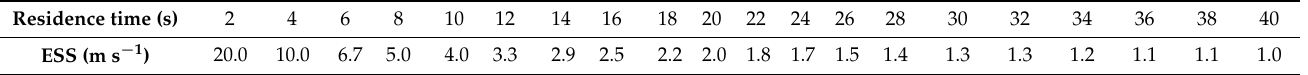
Table A2. Assuming that fish can only be tracked over a maximum distance of 40 m (e.g., fish passing along the bank opposite to the sonar bank, i.e., where it was immersed) and setting an obvious limit constraint at ESS < 5m s − 1 (above which swimming speed was not biologically realistic in our case study) and a Residence time ≥ 1 s, the theoretical function is as follows (maximum distance (m) of the sampling protocol divided by the residence time